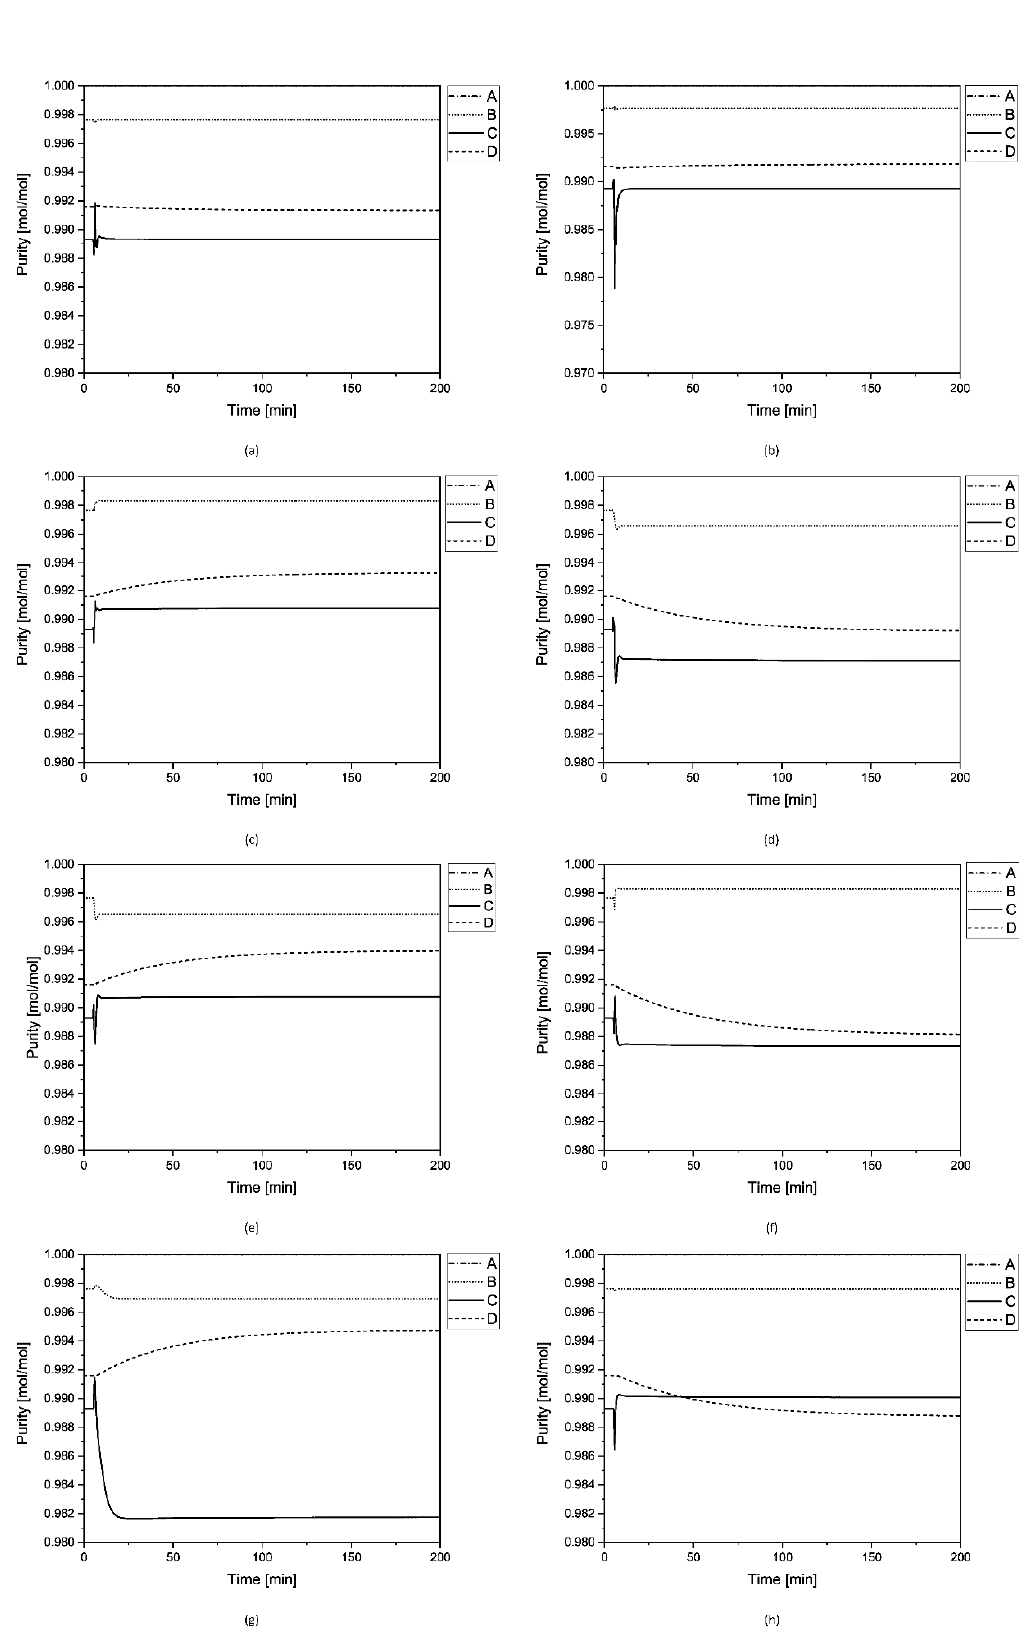
Figure 10. Simulated dynamic results on product qualities for mixture 2 for different disturbances: ( a ) scenario 1, ( b ) scenario 2, ( c ) scenario 3, ( d ) scenario 4, ( e ) scenario 5, ( f ) scenario 6, ( g ) scenario 7, and ( h ) scenario 8.